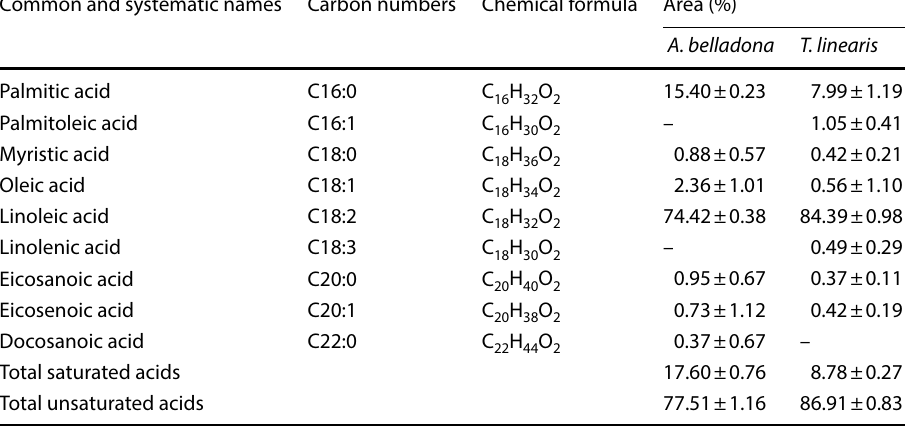
Table 2 Fatty acid composition of petroleum ether (PE) extracts of A. belladonna and T.